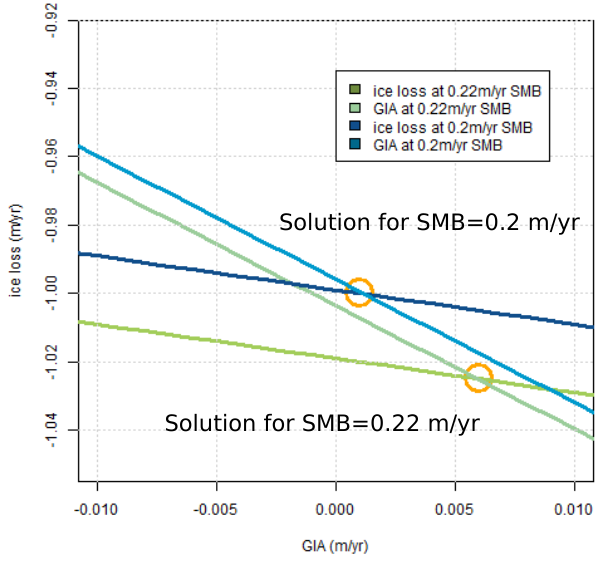
Figure 9. Toy example illustrating the sensitivity of combina- tion methods to differing SMB estimates. The blue lines repre- sent the set of equations that solve for ice loss and GIA when SMB = 0.2myr − 1 . The green lines represent the equations for SMB = 0.22myr − 1